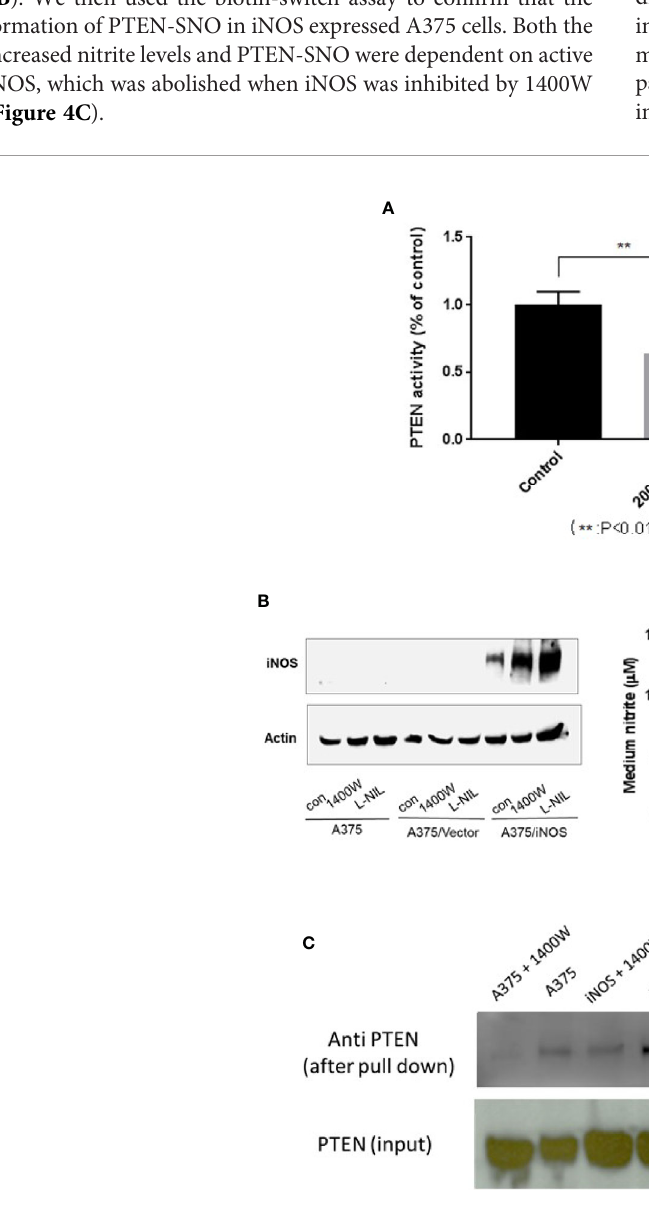
FIGURE 4 | PTEN phosphatase activity is attenuated and NO induced PTEN – SNO formation. (A) PTEN phosphatase activity in A375 cells treated with 200µM DETA NONOate was measured with a malachite green assay. (B) A375 cells were transfected to express iNOS and produce endogenous NO. Transfected iNOS was con fi rmed with western blotting, and nitrite formation was measured with the Griess reaction. NO generation from iNOS was inhabitable with the NOS inhibitors L-NIL or 1400W. (C) Using a biotin-switch assay, we detected PTEN S-nitrosylation in A375 cells expressing